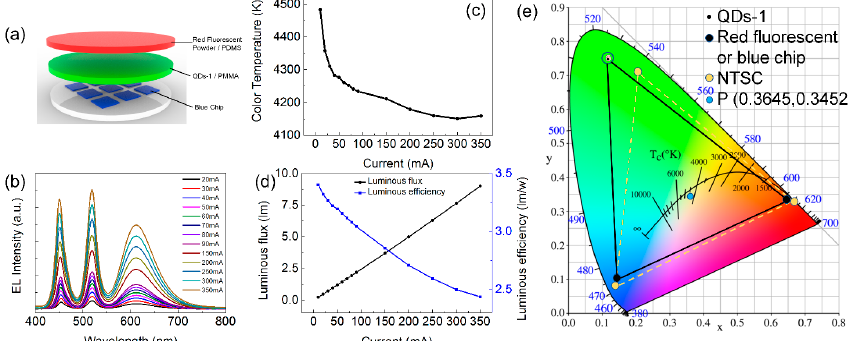
Figure 8. ( a ) Diagram of the LED device combining red fluorescent powder/PDMS composites, QDs-1/PMMA mixture with blue chips; ( b ) EL spectrum of the LED device at different currents; ( c ) color temperature of the LED device at different currents; ( d ) luminous flux and luminous efficiency of the LED device at different currents; ( e ) CIE color coordinates of QDs-1 at different currents and NTSC standard.